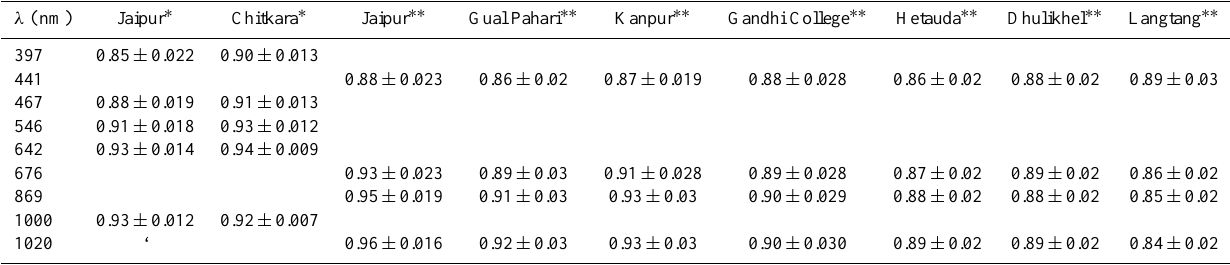
Table 2. Aerosol Single Scattering Albedo values obtained from our model calculations (indicated by *) and AERONET sunphotometer measurements (indicated by **), for the 2009 premonsoon period, over various measurement sites at near-Desert (Jaipur), Indo-Gangetic Plains (Gual Pahari, Kanpur, Gandhi College) and foothill/slope stations (Chitkara, Hetauda, Dhulikhel and Langtang). λ (nm) Jaipur ∗ Jaipur ∗∗ Gual Pahari ∗∗ Kanpur